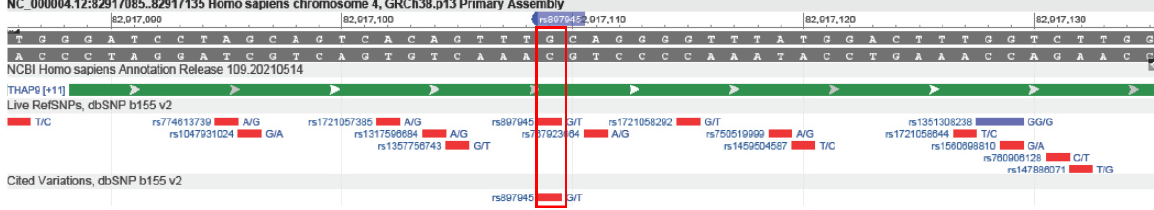
Figure 3. Genome Variation Viewer view of rs897945, which yields a G → T nucleotide substitution that leads to a Leu-to-Phe amino acid change at position 299 located on the Tnp_P_element (Pfam ID: PF12017) domain in hTHAP9 protein.